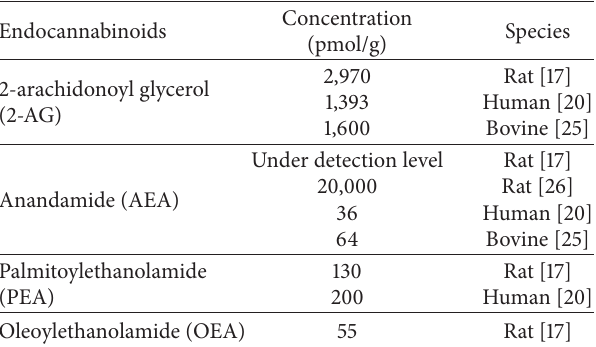
Table 1: Endocannabinoid levels in the adult retina of various